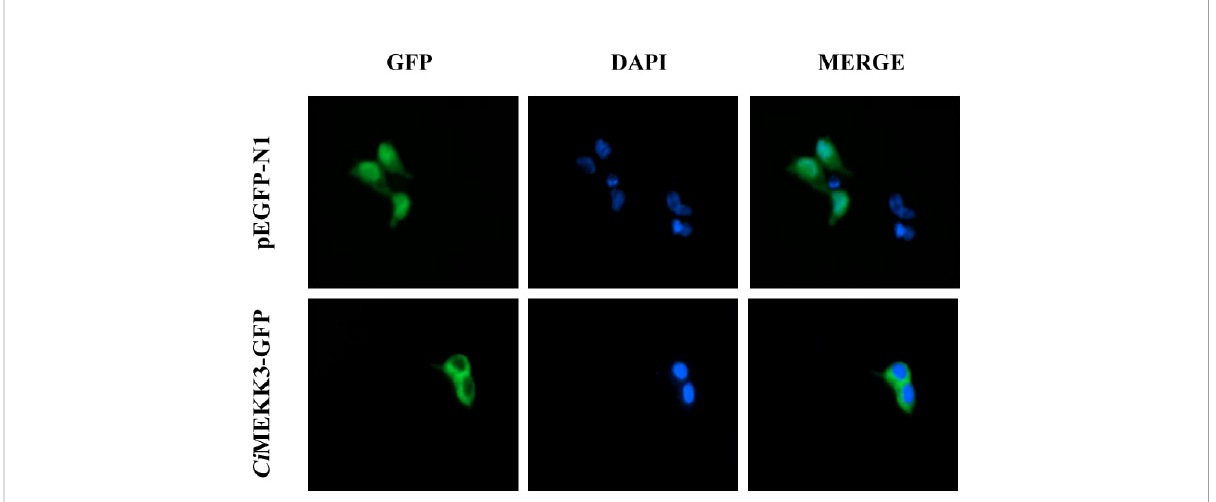
FIGURE 6 Subcellular localization of Ci MEKK3 in HEK293T cells. HEK293T cells were transfected with pEGFP-N1 (upper row) or Ci MEKK3-GFP (lower row). At 48 h post-transfection, the cells were fi xed with 4% paraformaldehyde, stained with 4 ′ ,6-diamidino-2-phenylindole (DAPI), and then observed with fl uorescence